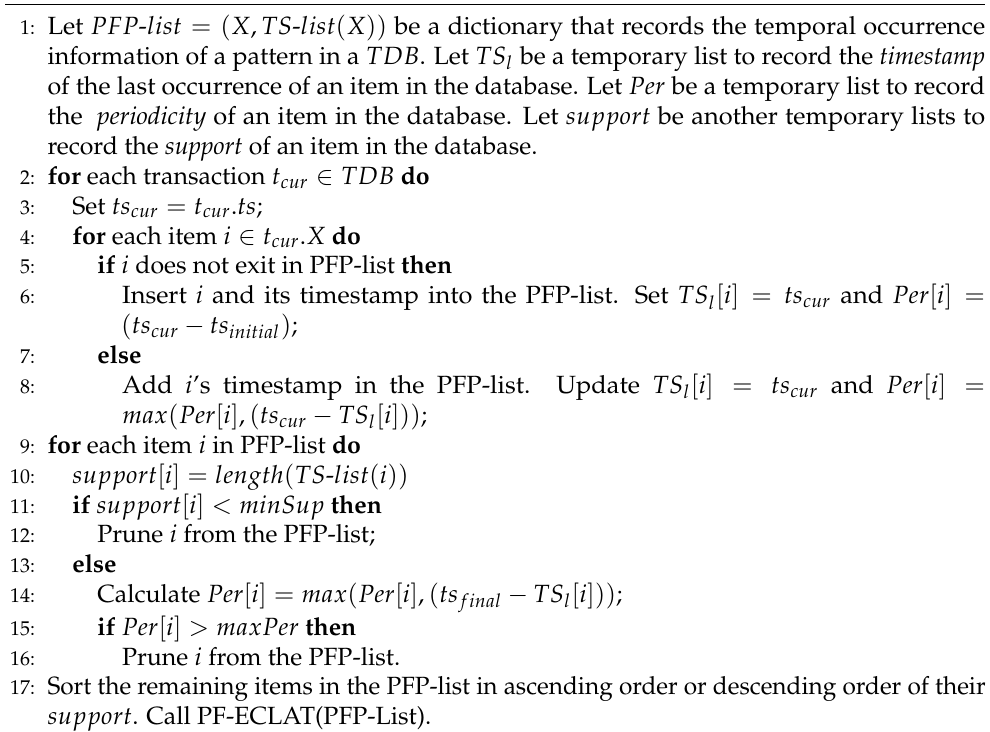
Algorithm 1 PeriodicFrequentItems(Row database ( TDB ), minimum support ( minSup ), maximum periodicity ( maxPer